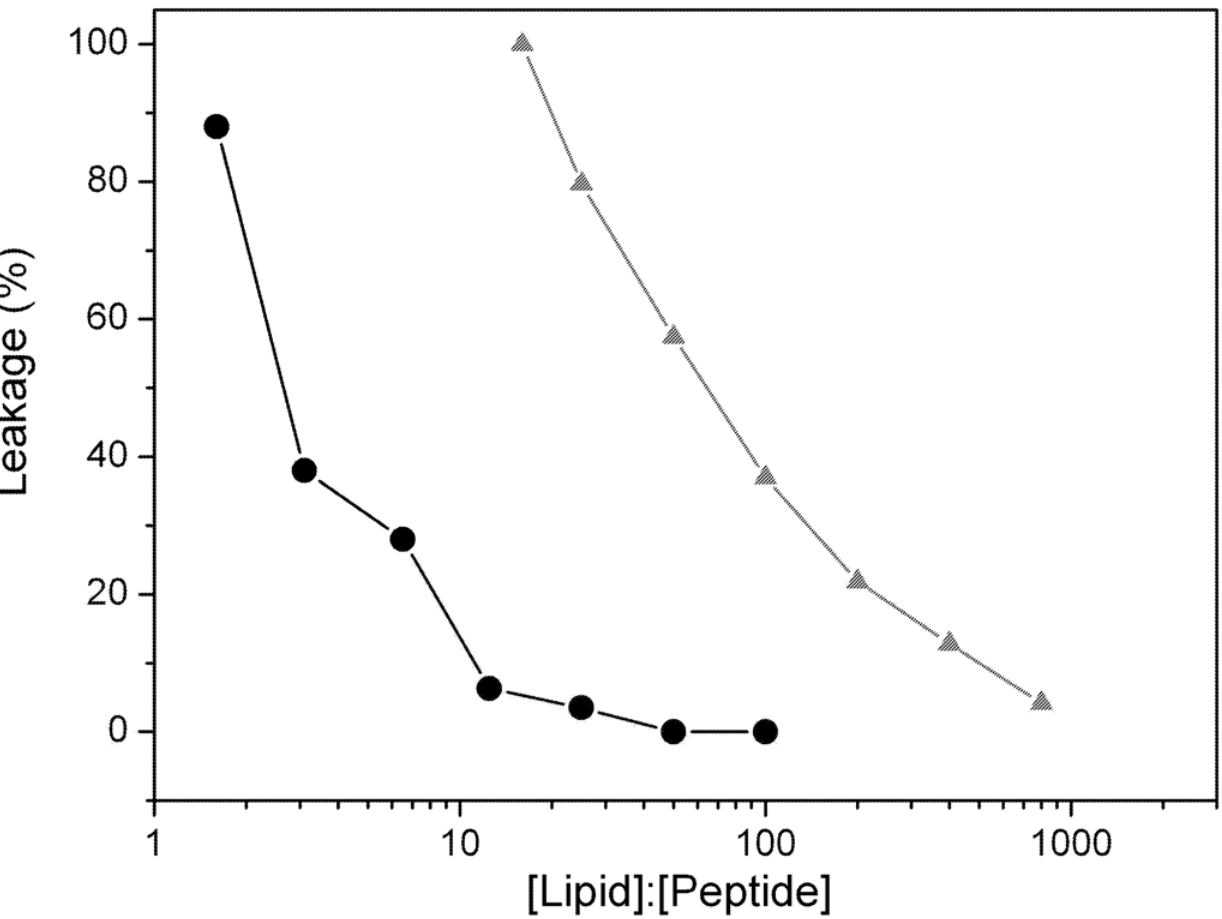
Fig 4. Integrity of LUVs in the presence of the peptides. Comparative leakage curves of Sit1 (black circles) and Sit2 (grey triangles) at different lipid: peptide molar ratios, after 10 min of incubation at 25°C.